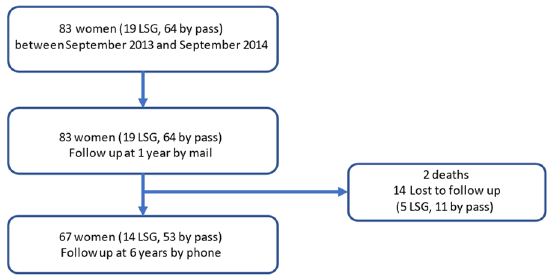
Figure 1. Flow chart of follow-up.